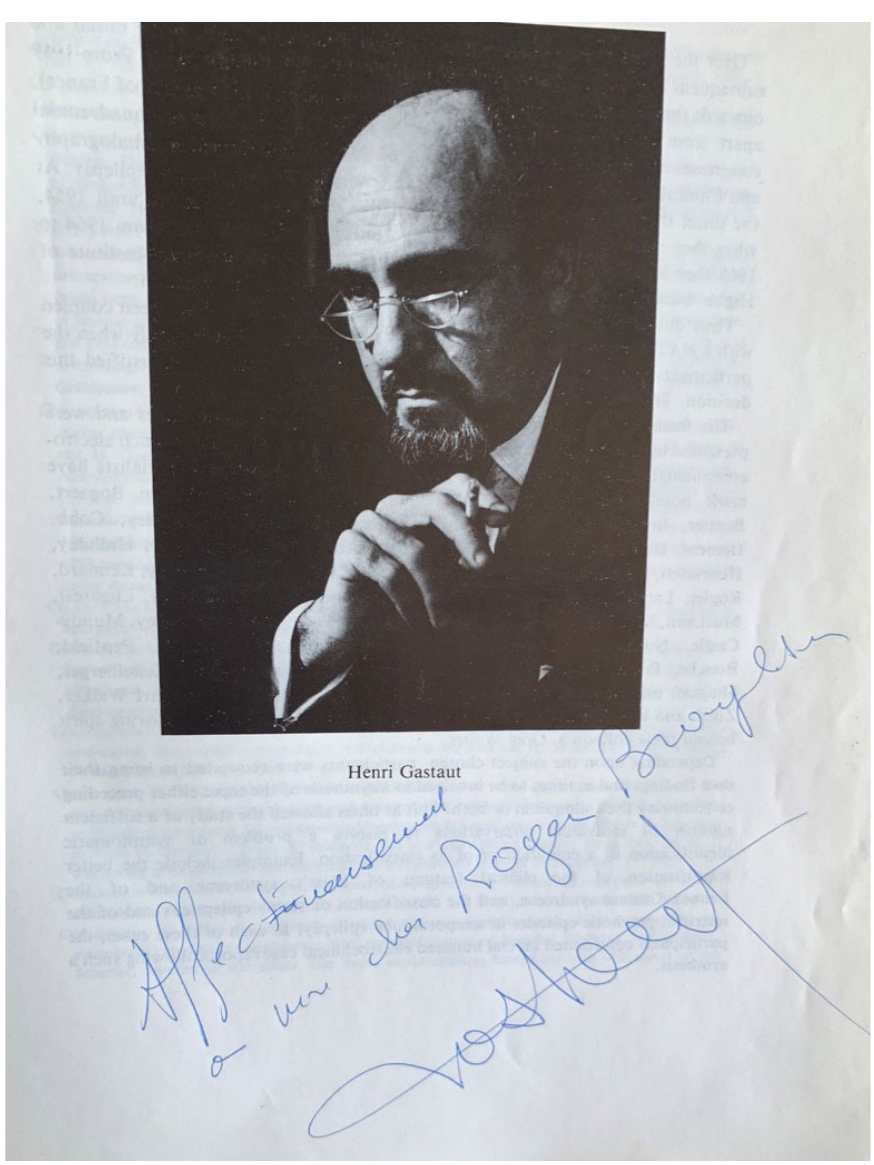
Figure 1. Professor Henri Gastaut (1915–1996) the director of the research program in the 1960s on sleep and sleep disorders which took place at the Centre Saint Paul in Marseille. The photograph signed by Gastaut states “to my dear Roger Broughton with affection, Henri Gastaut”. When I arrived at the end of June in 1962, Jack Rhodes from New Mexico, USA, was helping Batini in her research and several articles on normal sleep had already been pub ‐ lished in English or French journals. These were the first published sleep studies by the Marseille group and were authored by Batini, Fressy and Gastaut [1,2]. Jacques Fressy was a psychiatrist in the French army who wrote an excellent doctoral “thèse du 3ème cycle” on polysomnographic techniques [3]. Almost all of the research in this thesis was performed at the Centre Saint Paul and the main features were either initiated or were improved in Marseille. They included: